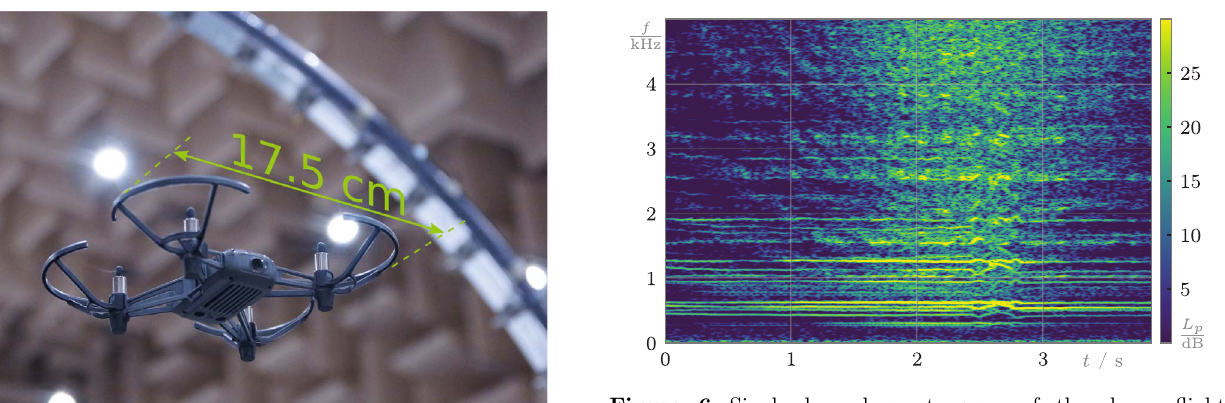
Figure 6. Single-channel spectrogram of the drone fl ight Table 1. Important parameters for the trajectory detection.